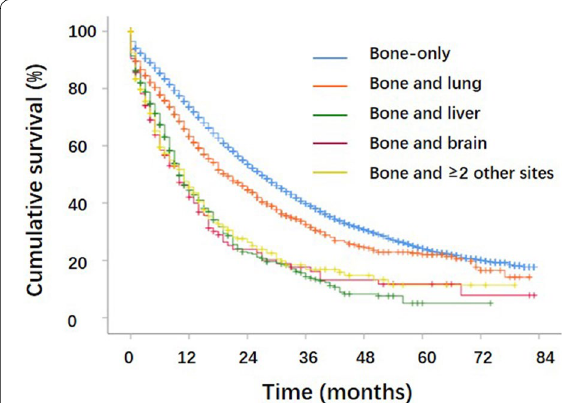
Fig. 2 Kaplan-Meier survival curves and log-rank tests showing that overall survival (OS) differences between prostate cancer patients with bone-only metastases, bone and lung metastases, bone and liver metastases, bone and brain metastases, and bone and sites metastases (i.e., bone-only vs bone and lung, bone-only vs bone and liver, bone-only vs bone and brain, and bone-only vs bone and 2 other sites, all p < 0.001; bone and lung vs bone and liver, ≥ bone and lung vs bone and brain, bone and lung vs bone and other sites, all p < 0.001; bone and liver, bone and brain, and bone and 2 other sites, compared with each other, all p > ≥